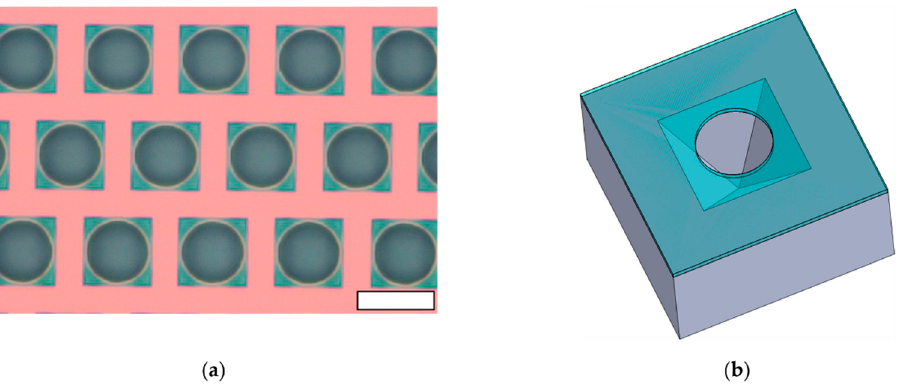
Figure 10. ( a ) Top-view microscope image of the inverted pyramids etched in Si by anisotropic etching under the SiO 2 hard-mask as shown in the sketch in ( b ) (where the SiO 2 hard-mask is shown in blue). The scale-bar is 10 µm.